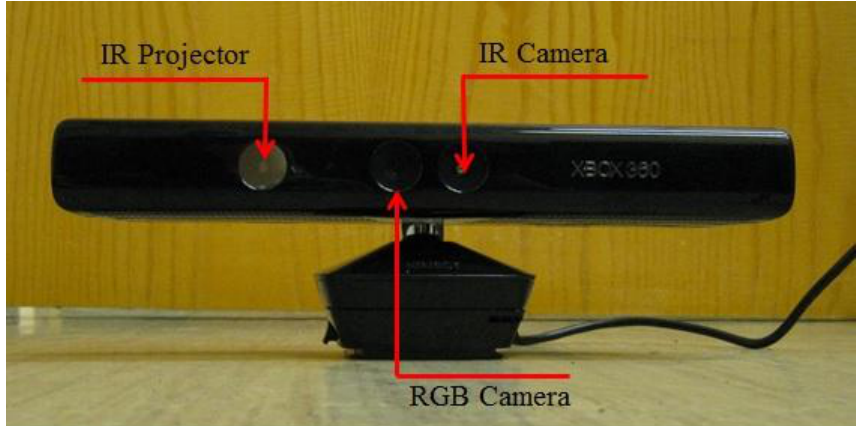
Figure 1. The Microsoft